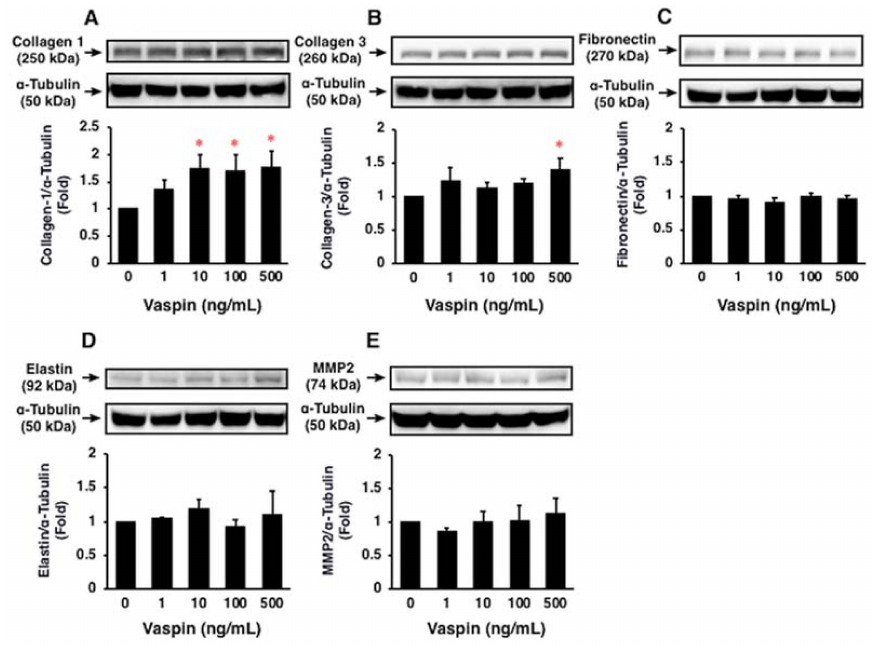
Figure 5. Effects of vaspin on ECM expression in HASMCs were assessed by immunoblotting. The blottted membranes were cut for reacting with different antibodies, and the blots were stripped and reprobed in the same membrane. Top: Representative results of protein expression of collagen 1 ( A ), collagen 3 ( B ), fibronectin ( C ), elastin ( D ), and MMP2 ( E ). Bottom: Densitometric data of each molecule after normalization relative to α -tubulin ( n = 3–4). * p < 0.05 vs. 0 ng/mL of